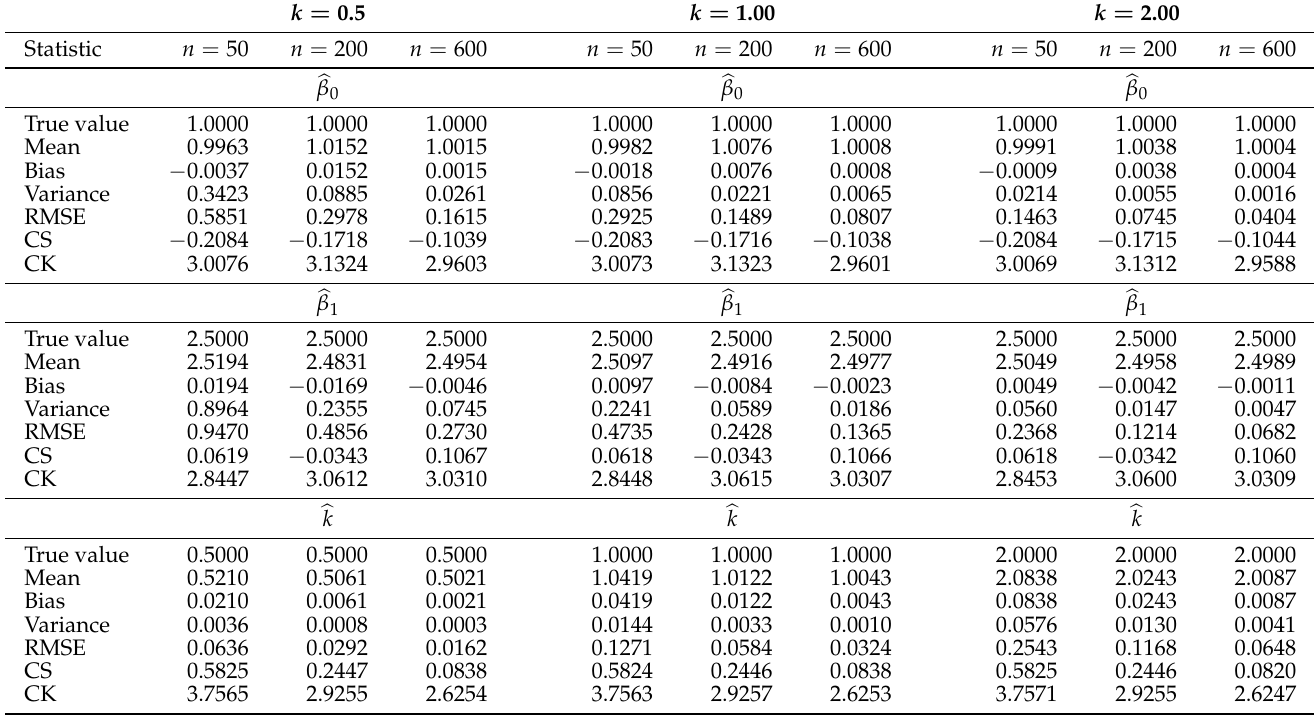
Table 6. Statistics from simulated Weibull regression data ( q = 0.50, β 0 = 1.00, β 1 = 2.50). k = 0.5 k =